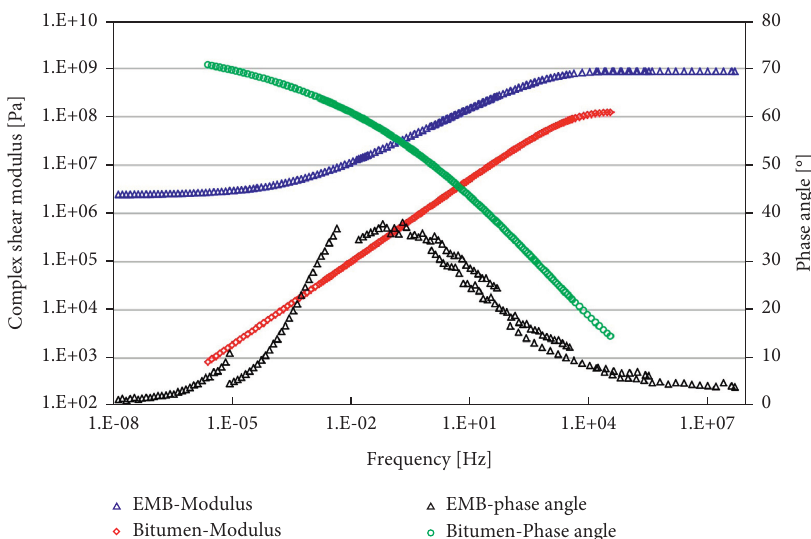
Figure 20: Complex modulus and phase angle for binders [100]. Note: EMB � epoxy-modified bitumen.